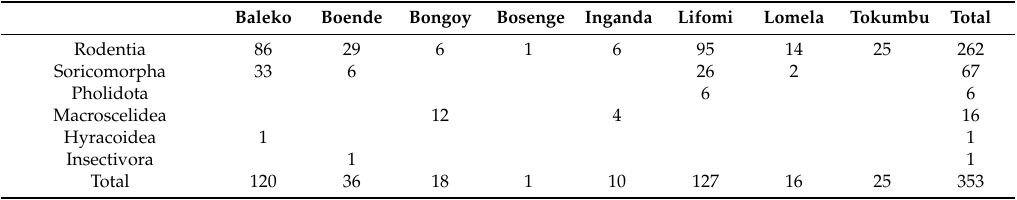
Table 1. Mammals collected by taxonomic order and location, the Democratic Republic of the Congo